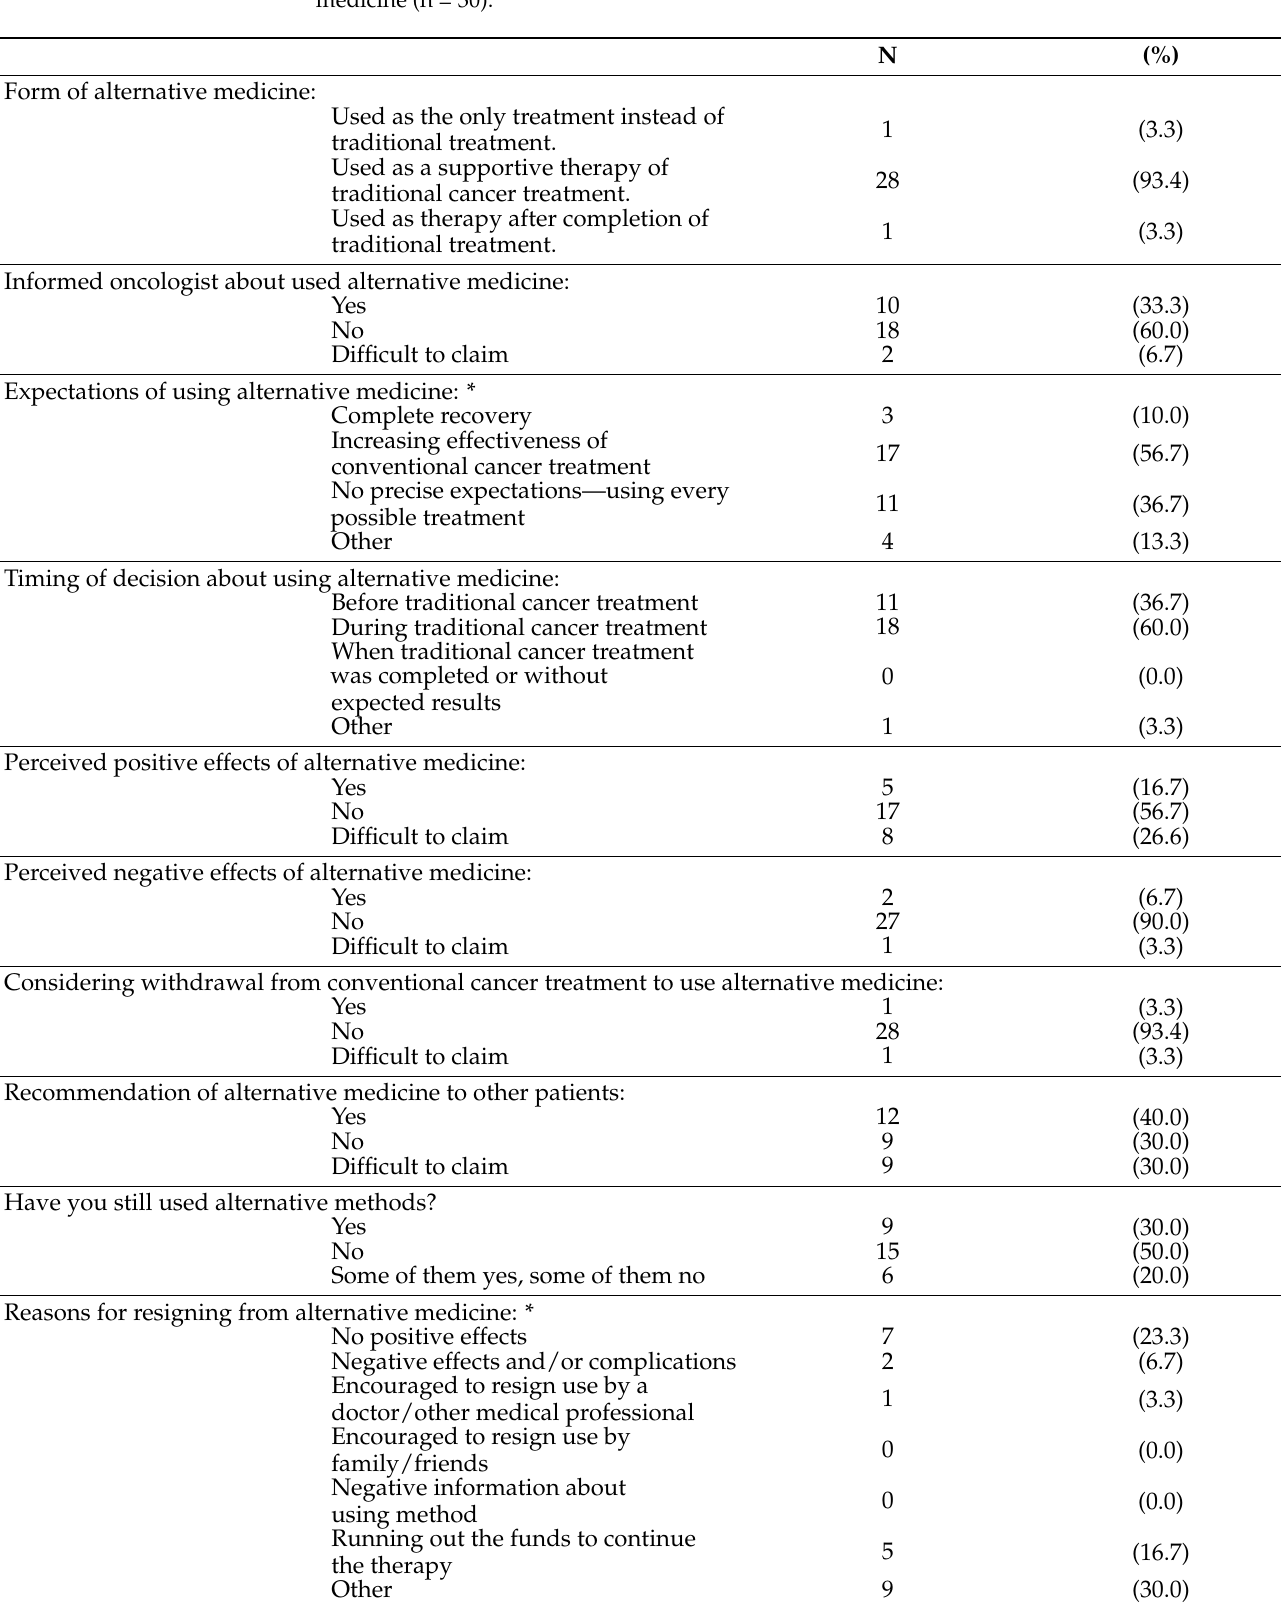
Table 2. The answers of patients who declared that they had used CAM as an alternative medicine (n =